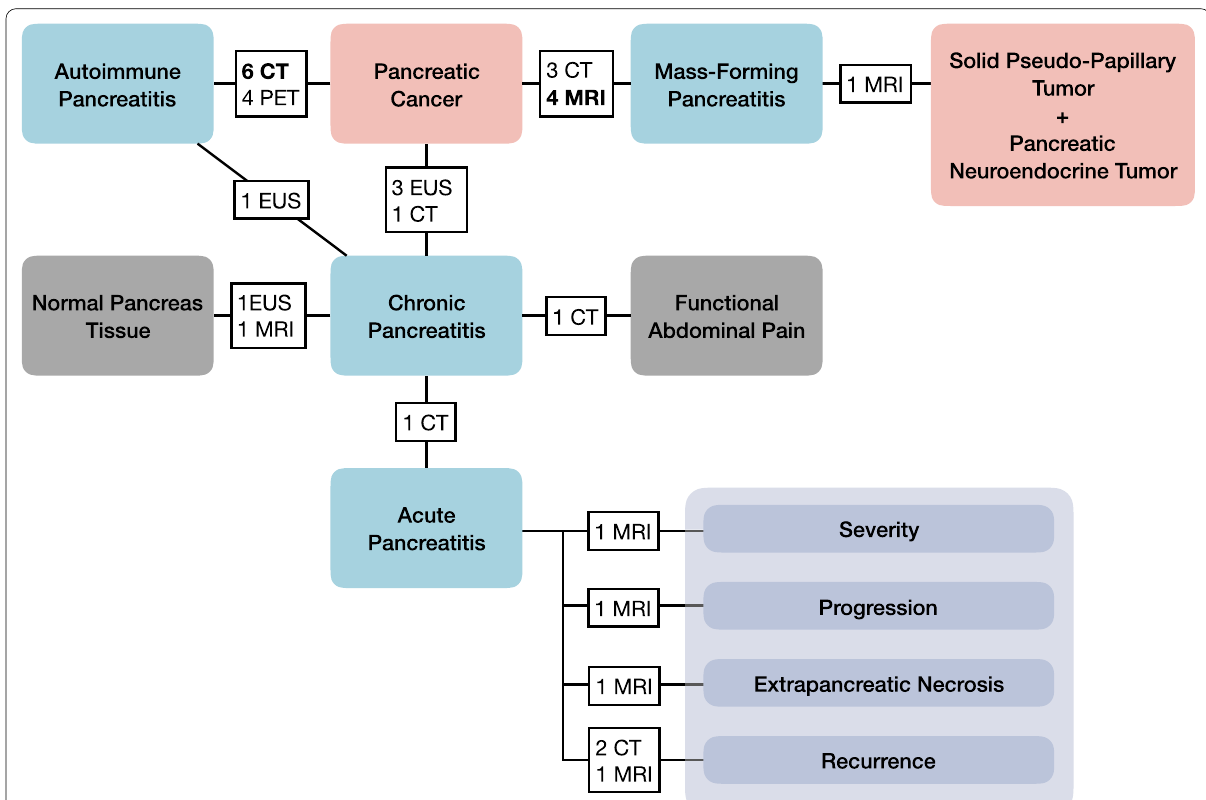
Fig. 2 Study topics and number of studies. Three studies investigated two topics, respectively, and had been treated as two different studies in the term of topic. Therefore, there were thirty studies according to article, but thirty-three models according to topic. The bolded number with modality indicates the studies included in the